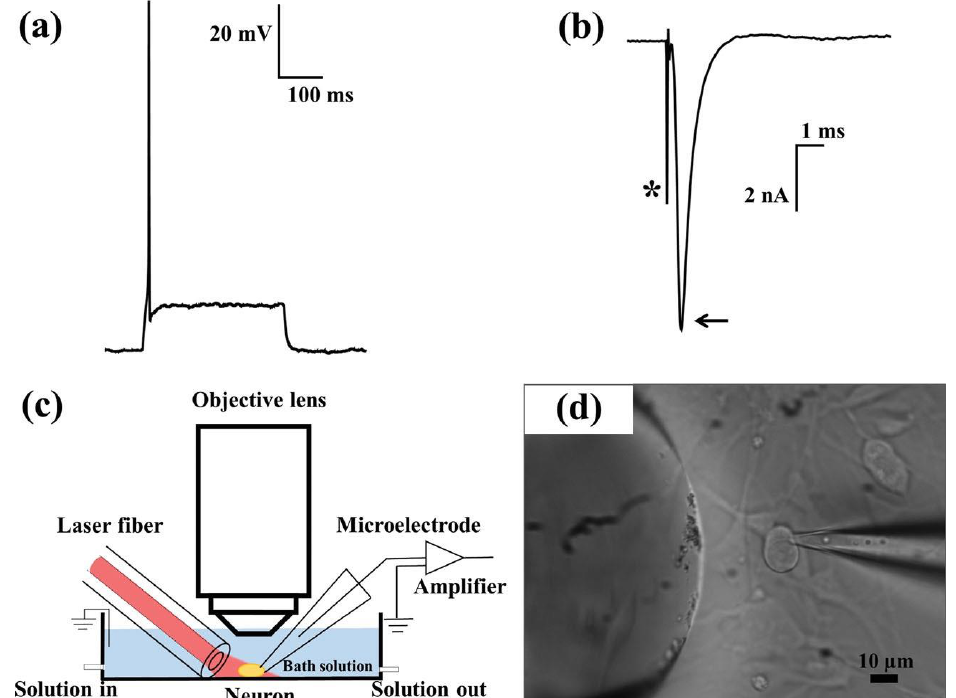
Figure 5. The typical response of a healthy neuron, held by whole-cell patch clamping, when exposed to certain stimuli. ( a ) A single action potential caused by a depolarizing current injection; ( b ) fast sodium currents during membrane depolarization in voltage-clamp (arrow). The stimulating electrode artifact is indicated with an asterisk. ( c ) The experimental setup for simultaneous laser stimulation and whole-cell patch clamp recordings on a neuron. ( d ) Phase-contrast image showing a patched neuron. Right: microelectrode; left: optical fiber. Reproduced with permission from [23]. John Wiley and Sons, 2014.